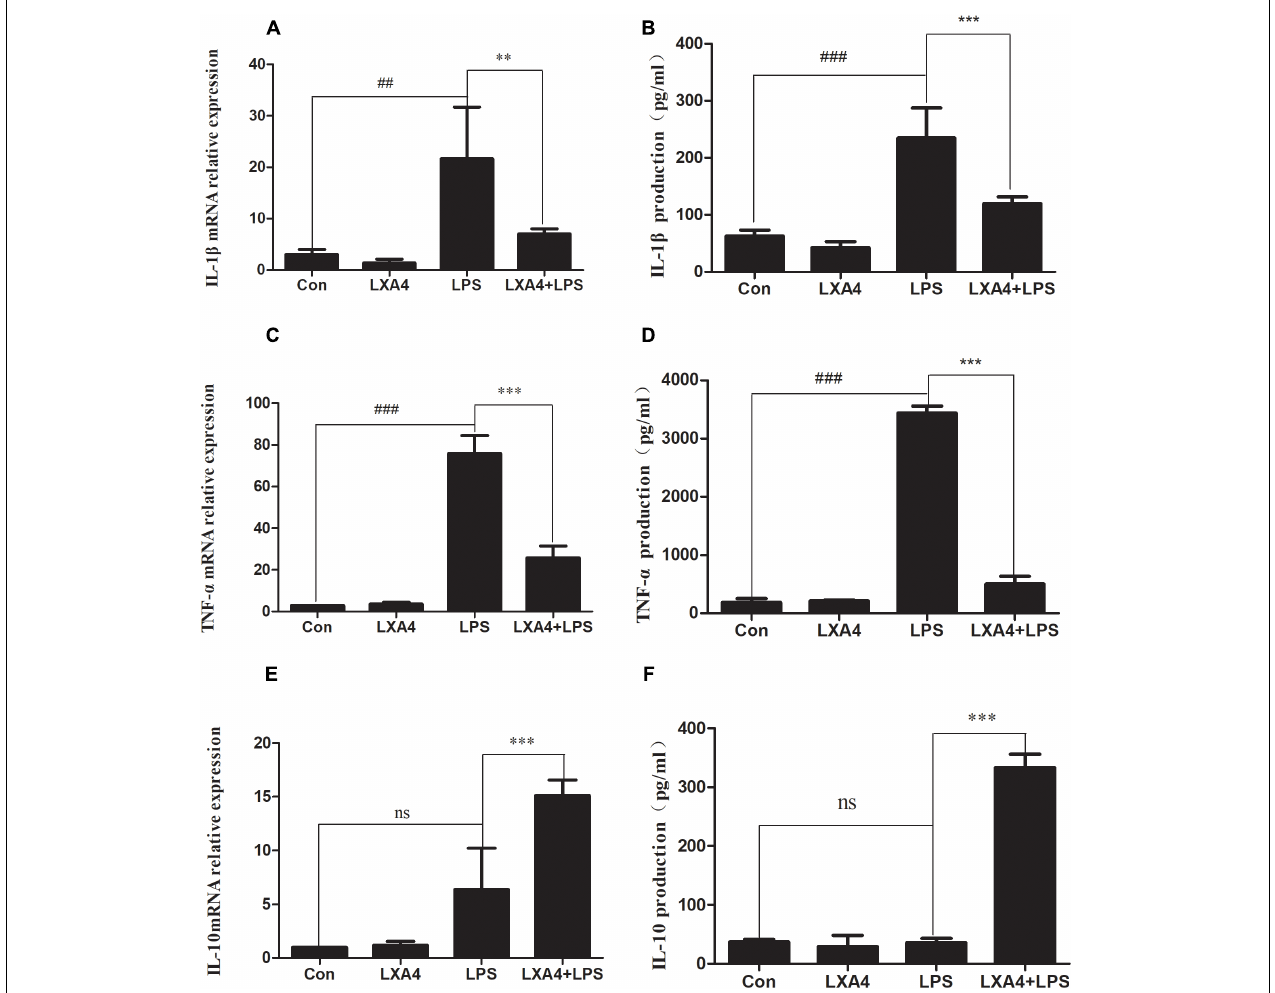
FIGURE 1 | LPS-induced microglia activation and release of inflammatory factors; After 6 h of LPS stimulating (A,C,E) : the mRNA expression levels of IL-1 β , TNF- α were measured by real-time fluorescent quantitative PCR; 8 h after LPS treatment, (B,D,F) The concentration of IL-1 β , TNF- α and IL-10 in the supernatant of the cells was detected by enzyme-linked immunosorbent assay (ELISA). LPS induces microglia activation, proinflammatory cytokines IL-1 β , TNF- α and anti-inflammatory factor IL-10 release. With LXA4 intervention, IL-1 β , TNF- α expression decreased, IL-10 expression increased significantly, ## , ∗∗ p < 0.01; ### , ∗∗∗ p < 0.001; n.s., no